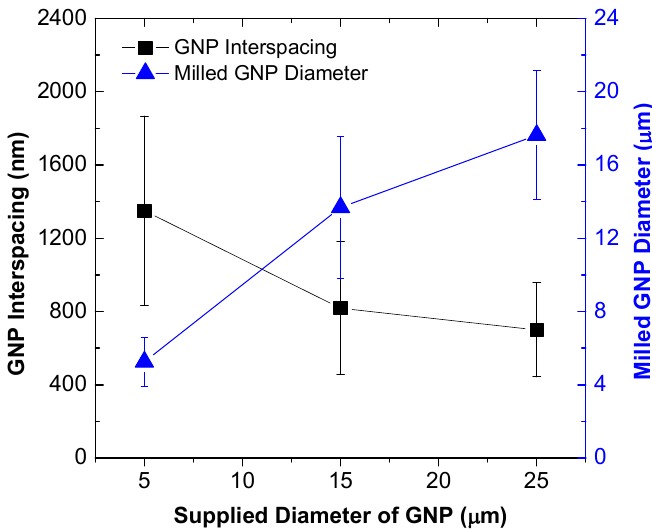
Figure 13. GNP interspacing and diameter after milling at varying supplied GNP diameters (i.e., H-series) in epoxy nanocomposite containing 10 wt % GNP.